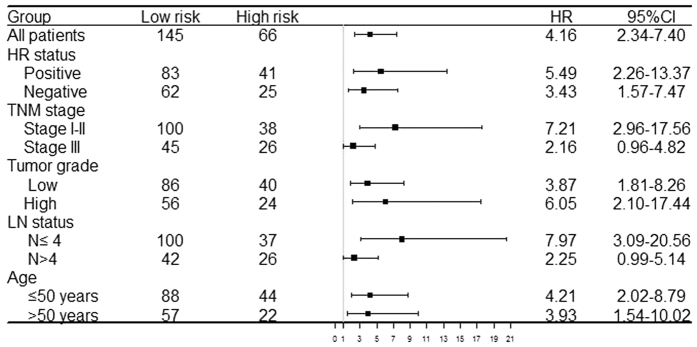
Effect of 2-miRNA based signature on DFS in different subgroups.